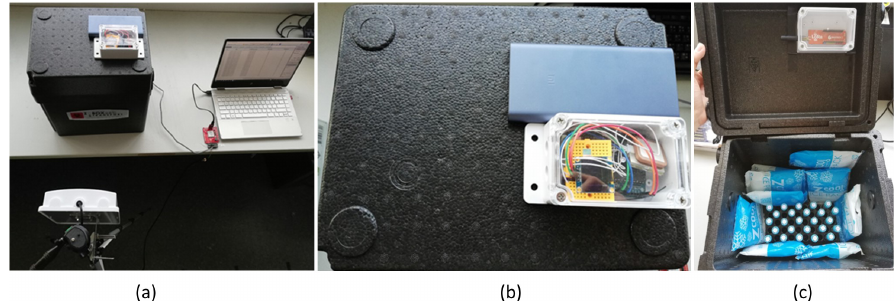
Figure 5. Our proposed RFID devices and smart specimen transport box using RFID and NB-IoT technologies. Overall proposed system ( a ), top-view of the specimen transport box ( b ), and tubes placed inside the box ( c ).